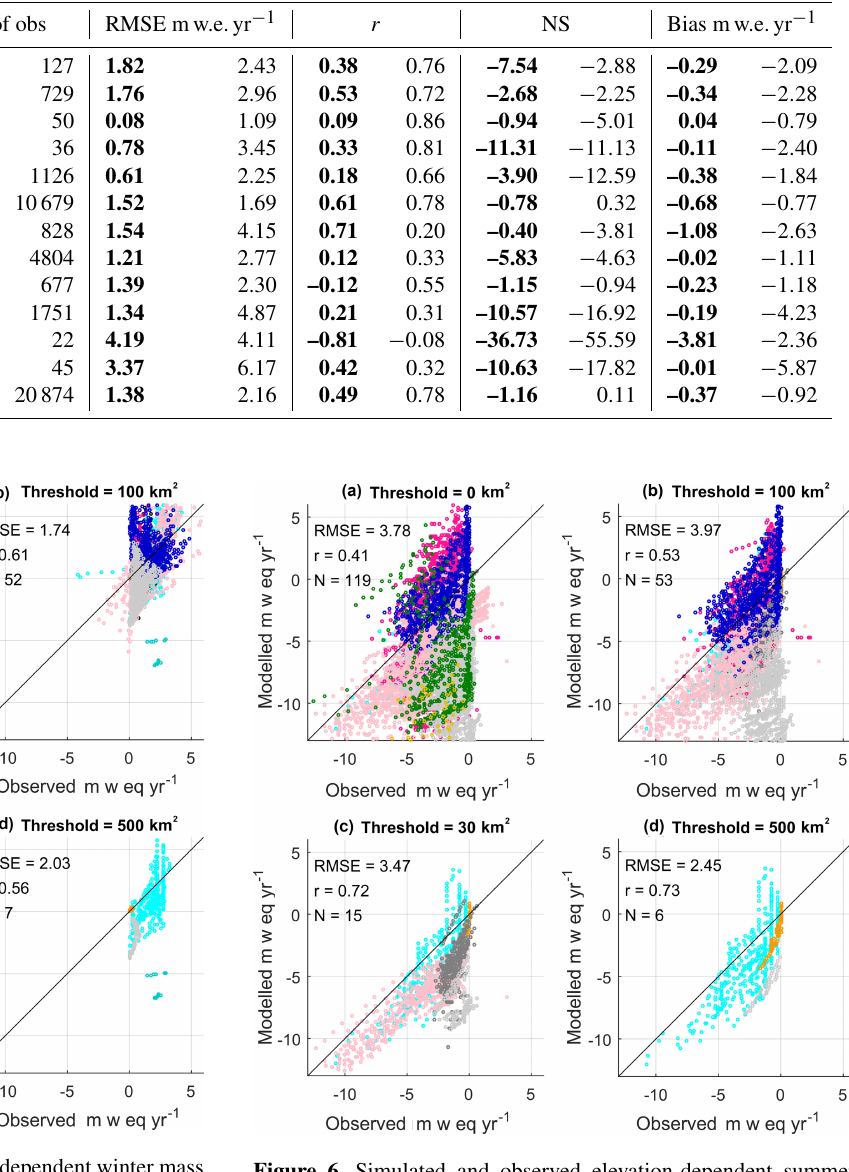
Table 4. Winter (bold) and summer number of elevation-band mass balance observations (No. of obs), root-mean-square error (RMSE), correlation coefficient ( r ), Nash–Sutcliffe efficiency coefficient (NS), and mean bias (Bias).